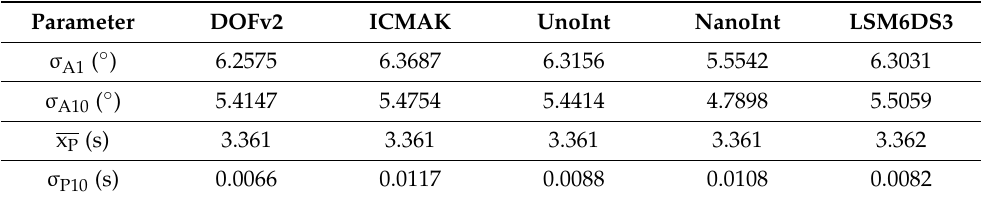
Table 2. Statistical analysis of the orientation data calculated from raw sensor data obtained from DIY devices.